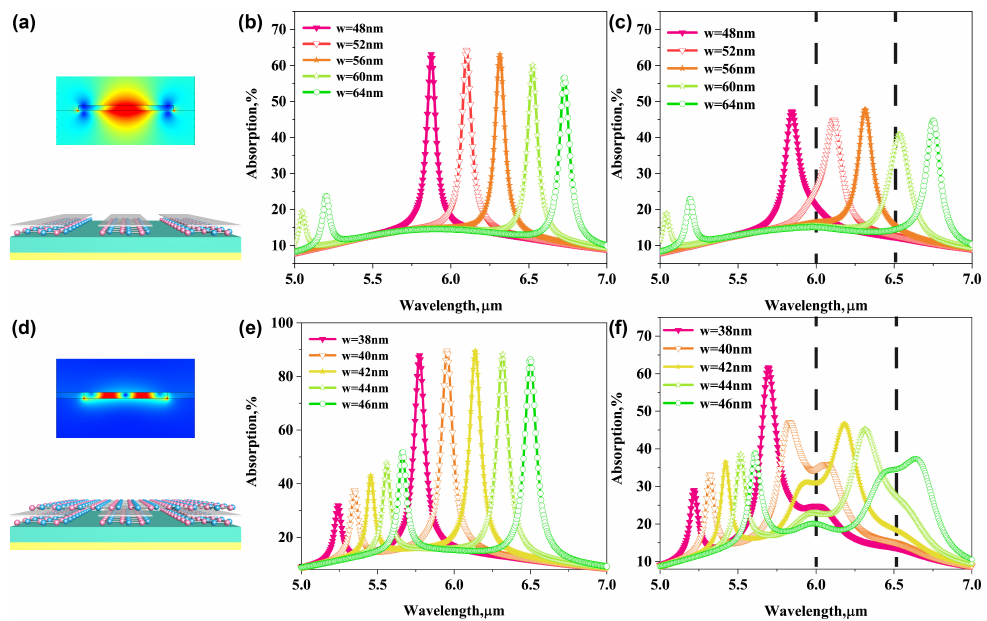
Figure 6. Electric filed distribution of ( a ) conventional GP biosensor and ( d ) bilayer AGP mid- IR biosensor. ( b ) Extinction spectra of the GP system by varying width w of graphene ribbons. ( c ) Extinction spectra of the GP system with 3 nm protein in nano-gap by varying width w of graphene ribbons. ( e ) Extinction spectra of the bilayer AGP system by varying width w of graphene ribbons. ( f ) Extinction spectra of the bilayer AGP system with 3nm protein in nano-gap by varying width w of graphene